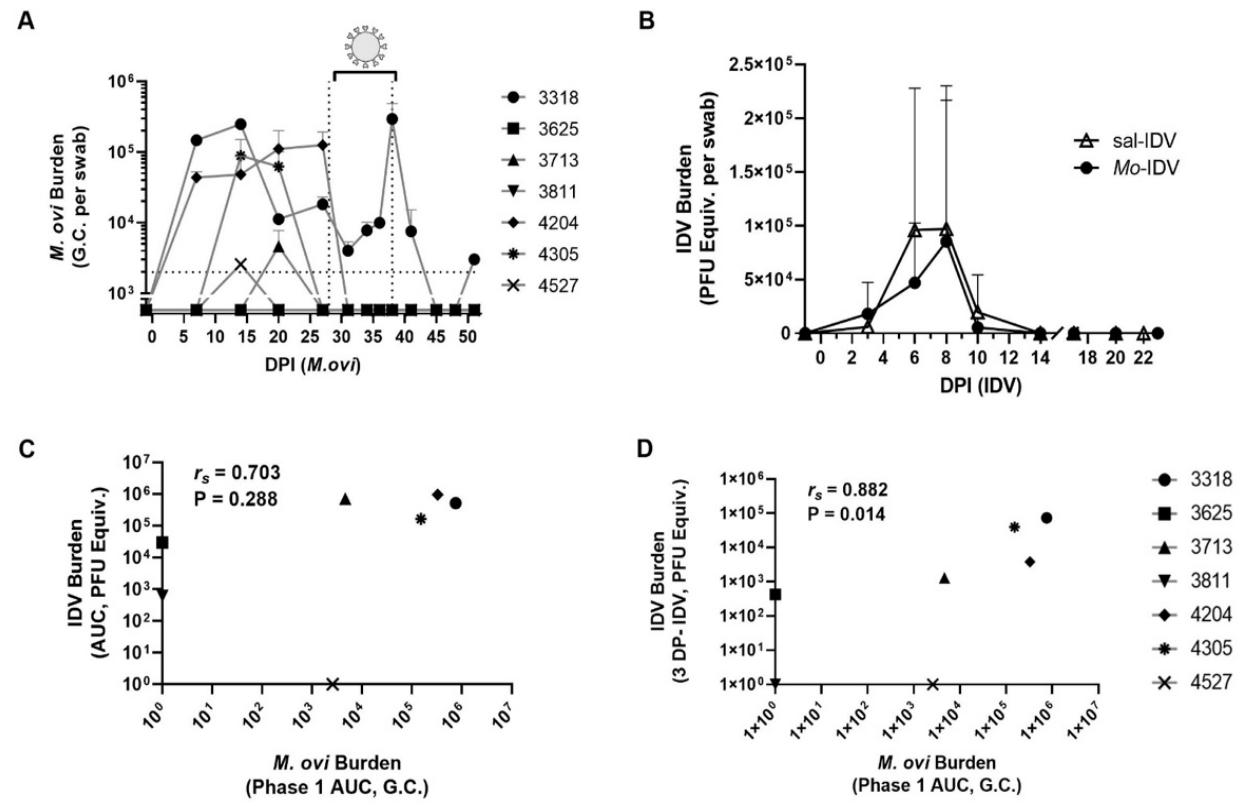
Figure 2. Recent M. ovipneumoniae infection correlates to early IDV shedding. Nasal shedding was monitored over time for ( A ) M. ovipneumoniae , individual lambs and ( B ) IDV, mean for each group. ( C , D ) Scatterplot showing correlation between total M. ovipneumoniae burden and ( C ) total IDV shedding, and ( D ) IDV shedding at 3 days post-IDV. Dotted horizontal line represents assay detection limit. Phase 1 AUC: area under the curve for phase 1 section of traces in ( A ); G.C.: enumeration of genome copies by qPCR; PFU Equiv.: enumeration of plaque-forming units by qRT-PCR; r s : Spearman correlation coefficient; P: p -value. Data presented as mean ± SD.